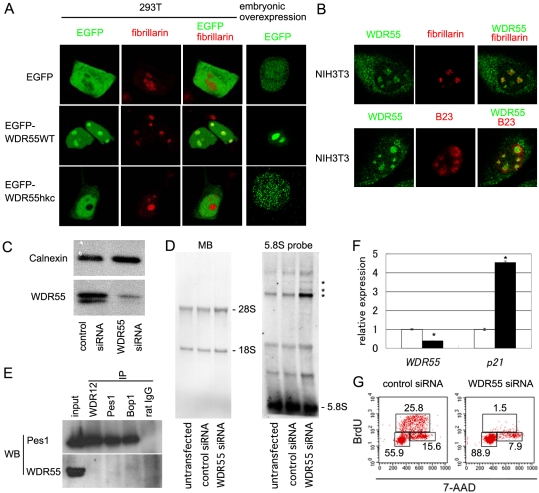
WDR55 modulates nucleolar rRNA production and cell cycle progression.(A) Intracellular localization of transfected EGFP, EGFP-WDR55WT, and EGFP-WDR55hkc (green) along with co-transfected t-HcRed1-fibrillarin in 293T cells. Single fluorescence images and merged images are shown. Rightmost panels show images of single cells isolated from stage-19 embryos that were administered at 1-cell stage with mRNAs of indicated genes. (B) Localization of endogenous WDR55 in NIH3T3 cells identified by antibody staining. Single fluorescence images and merged images of WDR55 (green) and fibrillarin (red, top panels) or B23 (red, bottom panels) are shown. (C) Western blotting of whole cell lysates of control or WDR55-siRNA-transfected NIH3T3 cells at 44 hours after transfection using anti-calnexin or anti-WDR55 antibody. (D) Detection of rRNA processing intermediates by Northern blot hybridization with 5.8S rRNA probe of total RNA (0.5 µg per lane) isolated from untransfected, control-siRNA-transfected, and WDR55-siRNA-transfected NIH3T3 cells. Asterisks indicate accumulation of processing intermediates in NIH3T3 cells transfected with WDR55-siRNA. An image of methylene blue (MB) staining is also shown (left). The amount of housekeeping glyceraldehyde-3-phosphate dehydrogenase mRNA measured by quantitative RT-PCR was not significantly different among same-weight total cellular RNAs isolated from untransfected, control-siRNA-transfected, and WDR55-siRNA-transfected cells. Along with the data showing that the intensities of the bands for 28S, 18S, and 5.8S rRNAs were comparable among these three groups of cells, these results suggest that the total amounts of rRNAs were comparable among these three groups of cells. (E) Immunoprecipitation (IP) of U2OS cell lysates using anti-WDR12, anti-Pes1, and anti-Bop1 antibodies, or normal rat IgG. 2.5% of input lysate before IP was also electrophoresed. Western blot (WB) detection is shown for Pes1 (top) and WDR55 (bottom). (F) Quantitative RT-PCR analysis of indicated genes in control (open bars) and WDR55-siRNA-transfected (closed bars) NIH3T3 cells. Expression levels in control cells were normalized to 1. Results represent averages and standard errors of three independent measurements. Asterisks, p<0.05. (G) Cell cycle analysis of control (left) and WDR55-siRNA-transfected NIH3T3 cells by BrdU and 7-AAD staining. Numbers indicate frequency of cells in indicated squares. Lower left box, upper box, and lower right box show cells in G1 phase, S phase, and G2/M phase, respectively. Representative results of three independent experiments are shown.